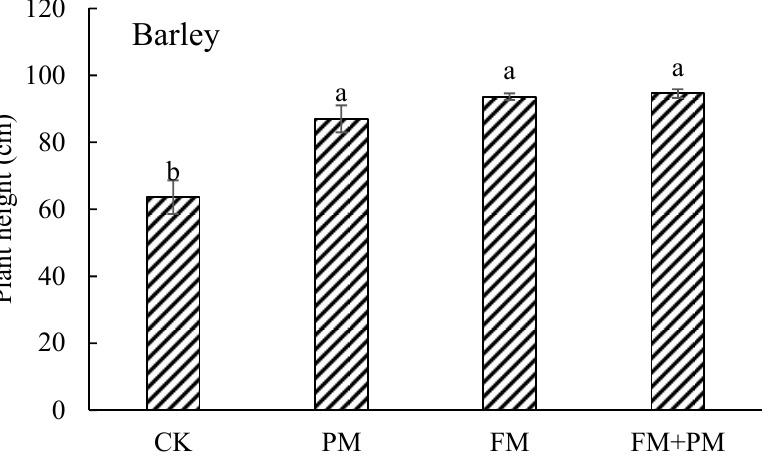
Figure 4. Plant height under CK, PM, FM, and PM+FM treatments. CK: control treatment, PM: plastic film mulch, FM: farmyard manure, PM+FM: plastic film mulch combined with farmyard manure. The vertical bars represent the standard deviations of the data and the values followed by the same letter are not significantly different (LSD, p < 0.05).